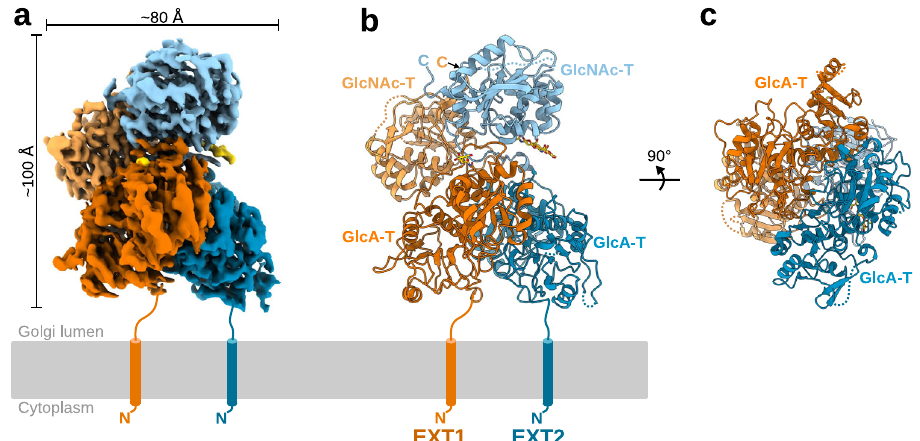
Fig. 2 | Structure of the human EXT1-EXT2 complex. a EM map of the hetero- dimeric EXT1-EXT2 complex, with density covering EXT1 in orange and EXT2 in blue. Both proteins harbor a glucuronic acid transferase (GlcA-T) domain and a N - acetylglucosamine transferase (GlcNAc-T) domain colored in darker and lighter shades, respectively. Densities of N -glycans are colored in yellow. The N-terminal